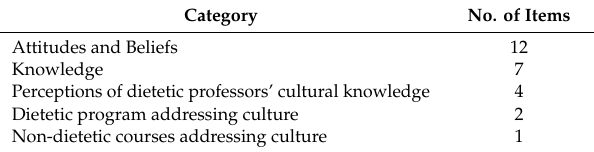
Table 1. Initial Categories for General Knowledge Attitudes and Beliefs